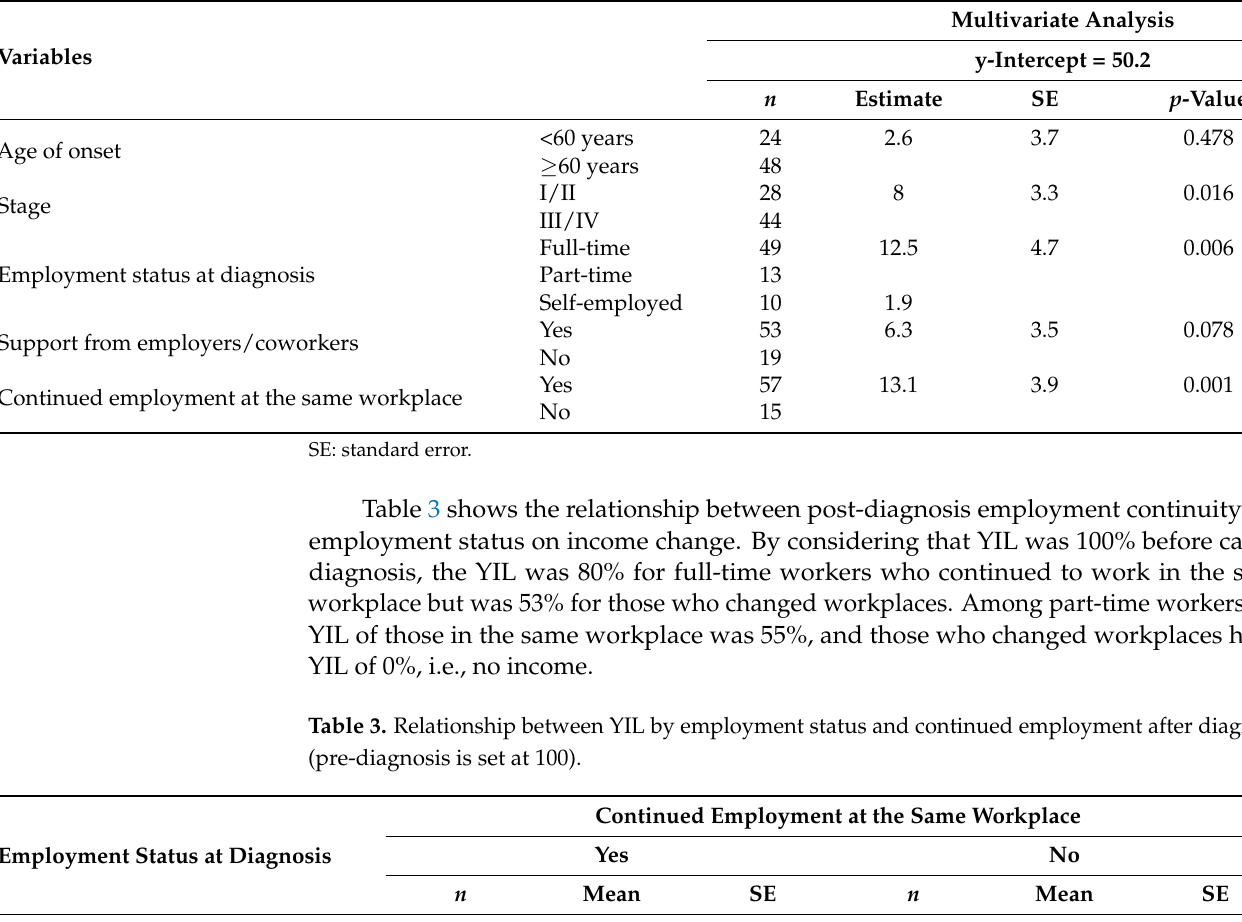
Table 2. Multivariate analysis of the income change: YIL % (pre-diagnosis is set at 100).